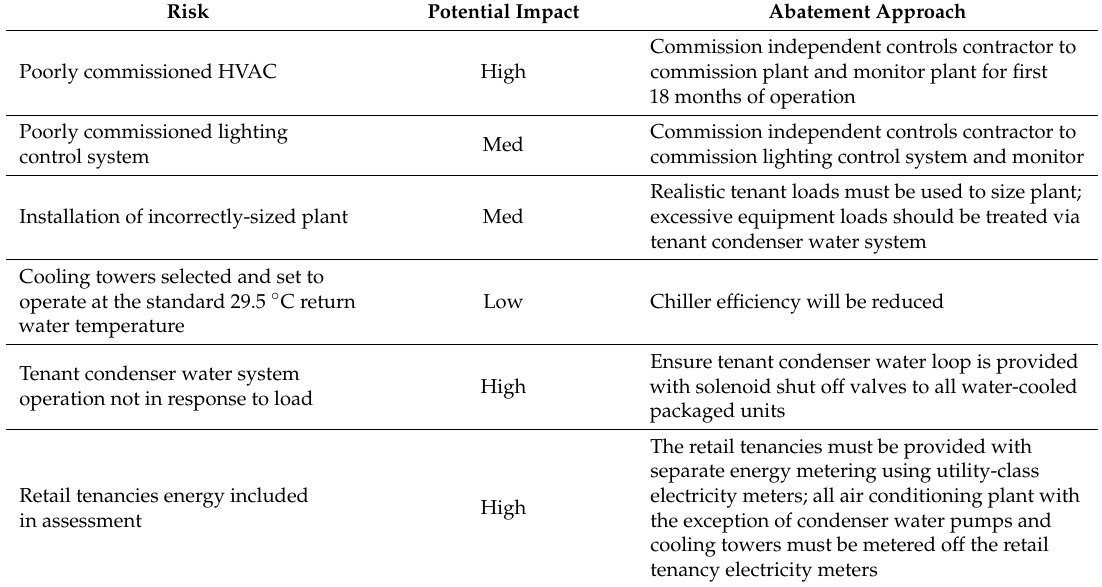
Table 8. Risk assessment